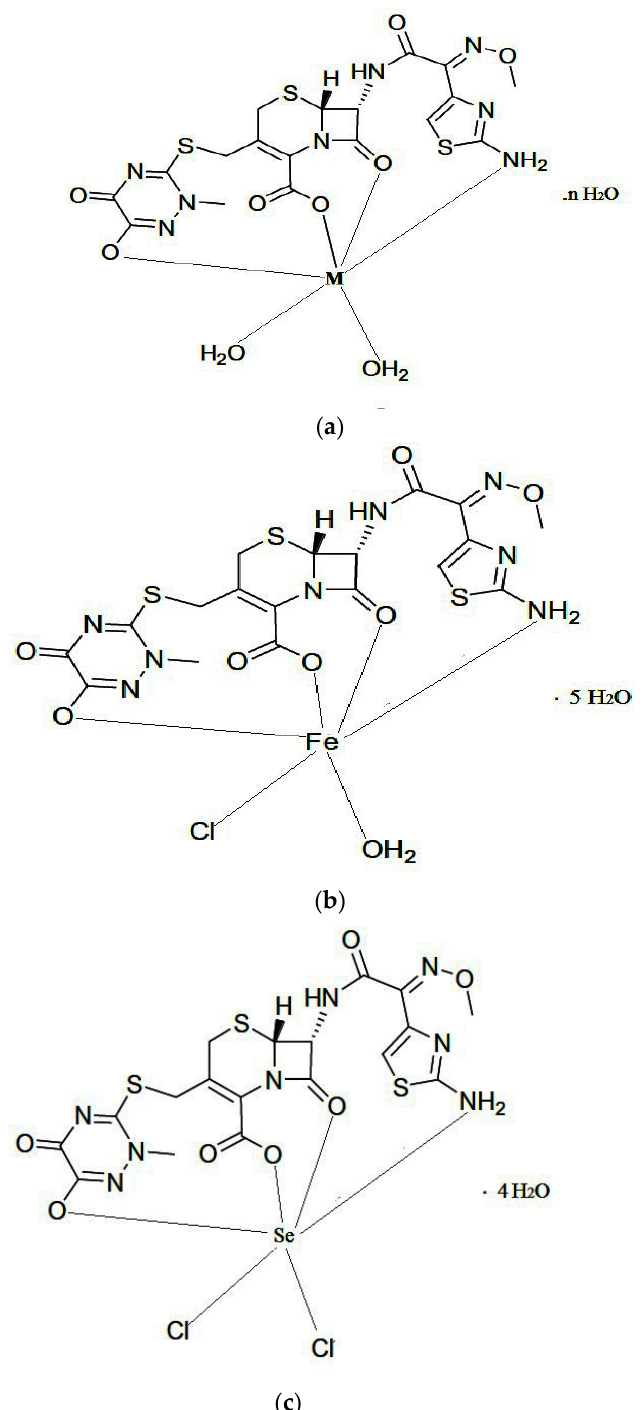
Figure 4. The structure of the prepared CFX complexes. ( a ) M = Mg, Cu and Zn/CFX, n = 4,3 and 6 respectively. ( b ) Fe/CFX complex. ( c ) Se /CFX complex.